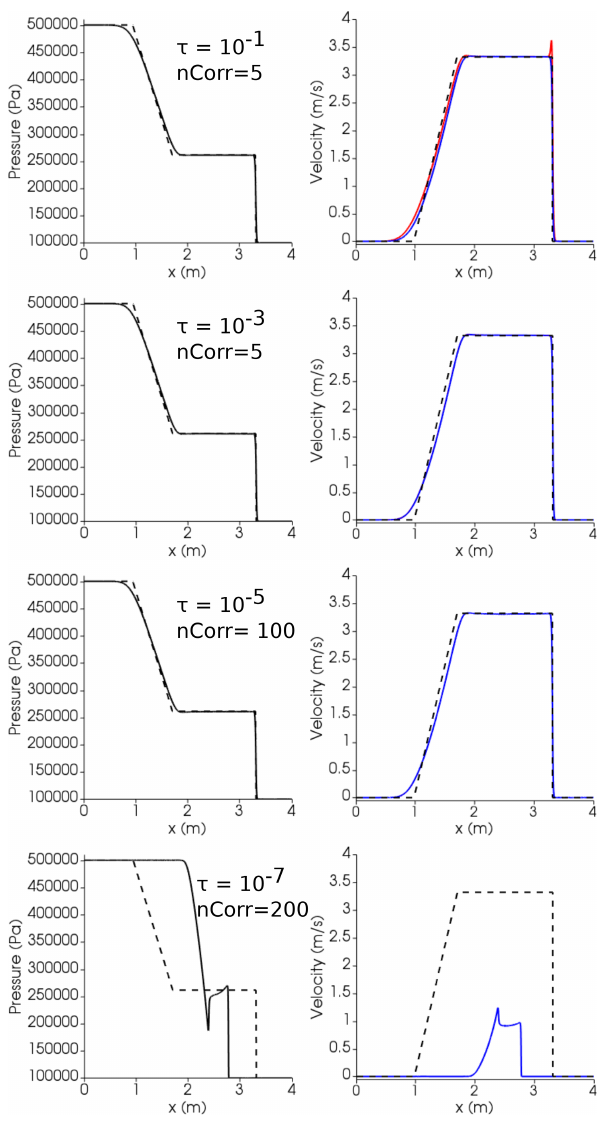
Figure 12. Air–water shock tube simulations at different relaxation times τ and number of correctors. Dashed lines: analytical solu- tion; solid lines: simulation. Blue lines: liquid (water); red lines: gas (air). At time 0, the interface dividing the high-pressure (left, l) from low-pressure (right, r) zone is placed at 2.5m. Initial conditions: P l = 0 . 5MPa, P r = 0 . 1MPa, and T l = T r = 300 K for both phases; gas volume fraction: α l = 0 . 05, α r = 0 . 1, and U l = U r = 0 for both = phases. Isobaric heat capacities of gas air and liquid water are C P g = 4195Jkg − 1 K − 1 , respectively (https: 1004 . 5Jkg − 1 K − 1 and C P l //webbook.nist.gov/, last access: 27 April 2022). Prandtl numbers of air and water are 0.7 and 2.289, respectively, corresponding to thermal conductivities of 0.02 and 0.67WK − 1 m − 1 , respectively (https://webbook.nist.gov/, last access: 27 April